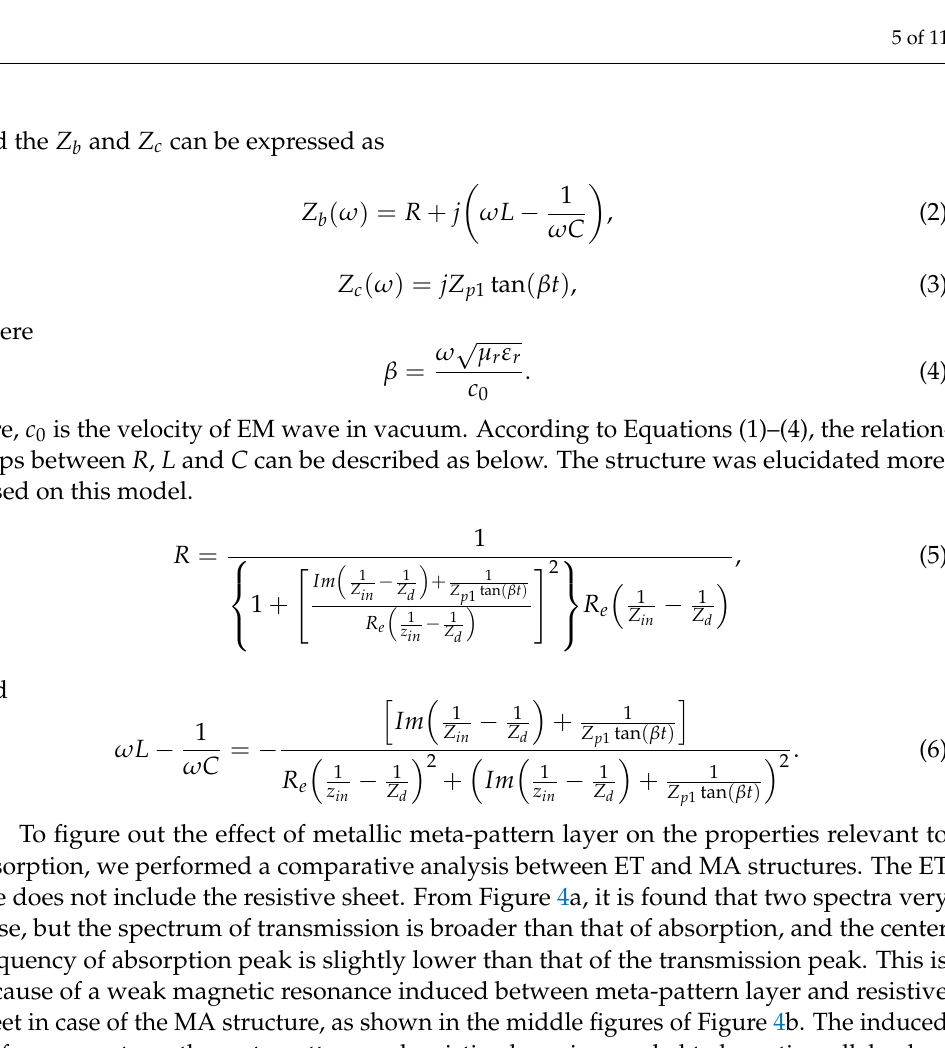
Figure 5. ( a ) Absorption spectra of the MA structure according to m . ( b ) Distribution of the power- loss density on the surfaces of polyimide 1 and resistive sheet. Figure 6. Absorption spectra by varying the thickness of polyimide 1.